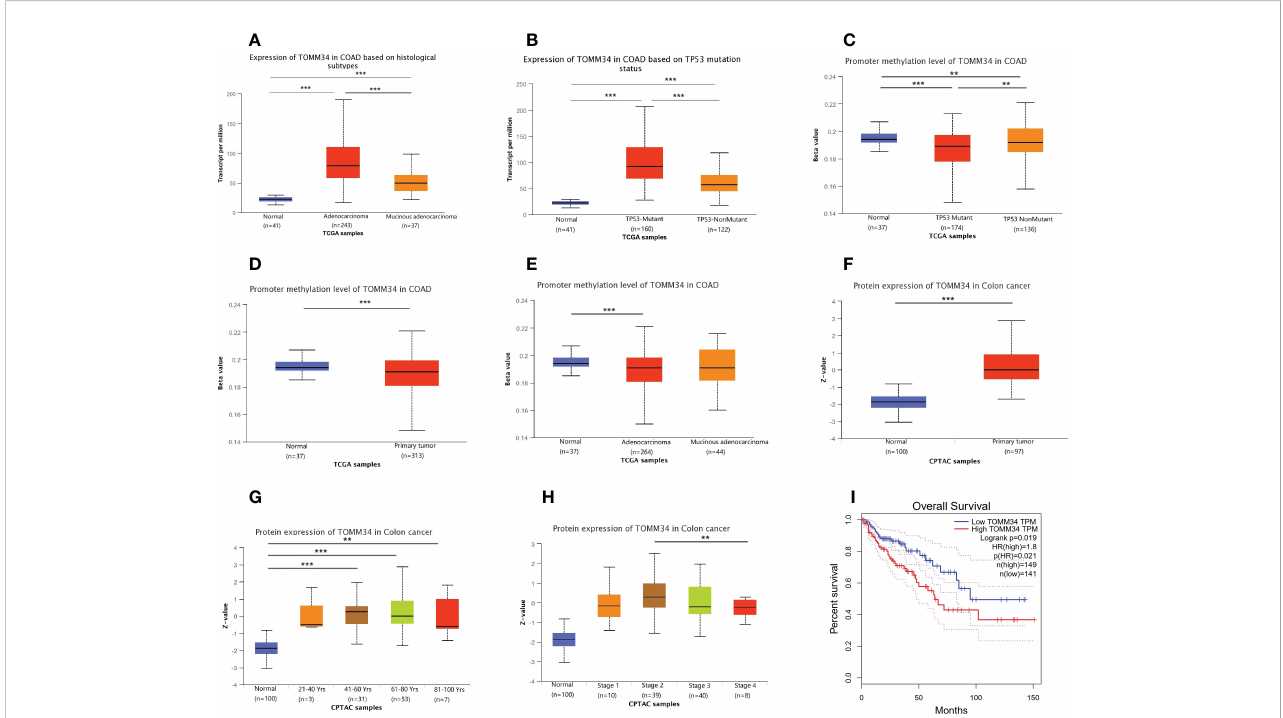
FIGURE 2 Correlation between TOMM34 expression and clinicopathological traits obtained from TCGA and CPTAC samples. (A) Histological subtypes from TCGA samples, indicating that TOMM34 expression was associated with histological subtype. (B) TP53 mutation status from TCGA samples, indicating that TOMM34 expression was associated with TP53 mutation status. (C) Promoter methylation level in distinct TP53 mutation statuses from TCGA samples, suggesting that TOMM34 expression was associated with TP53 mutation status. (D) Promoter methylation level in distinct sample types from TCGA samples, suggesting that TOMM34 expression was associated with sample type. (E) Promoter methylation levels in distinct histological subtypes from TCGA samples, suggesting that TOMM34 expression was associated with histological subtype. (F) Protein expression of TOMM34 in distinct sample types, revealing that proteomic expression of TOMM34 was upregulated in tumor tissues compared with normal tissues. (G) Protein expression of TOMM34 at different ages. (H) Protein expression of TOMM34 in distinct clinical stages. (I) Survival analysis of TOMM34 in overall survival, indicating that upregulation of TOMM34 was remarkably related to poor prognosis in overall survival. ***p<0.001, **0.001 ≤ p<0.01, *0.01 ≤